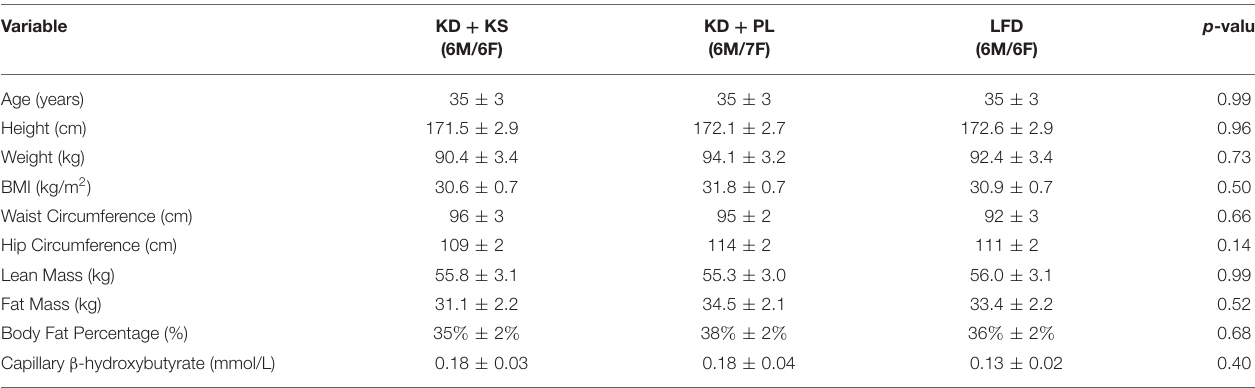
TABLE 1 | Baseline